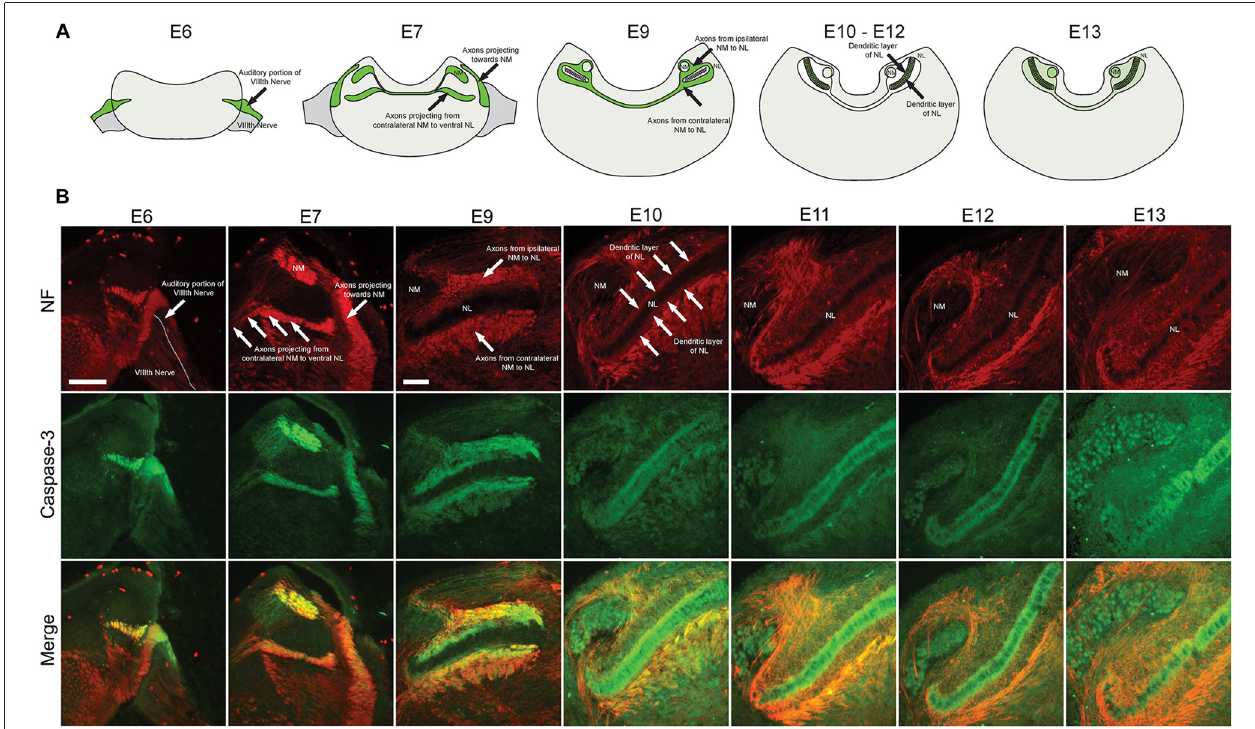
FIGURE 1 | Spatial and temporal expression of cleaved caspase-3 in the developing chick auditory brainstem. (A) Summary of cleaved caspase-3 expression (shown in green) from E6 to E13. (B) Expression of cleaved caspase-3 in the brainstem from E6 to E13. Neurofilament (NF) staining (red) shows the developmental progression of axonal tracts, with cleaved caspase-3 expression (green) closely following axonal tract development (merged). At E6 labeling is seen in the peripheral and central projections of the auditory VIIIth nerve fibers. At E7 central projections of auditory nerve fibers and their synaptic target, nucleus magnocellularis (NM), also shows labeled axons. At E9–10 NM axons are labeled. At E11–12 these NM fibers are no longer labeled, but expression is seen in dendrites of their synaptic target, nucleus laminaris (NL). Scale bar for E6 = 100 µ m, applies to E6–7. Scale bar for E9 = 100 µ m, applies to